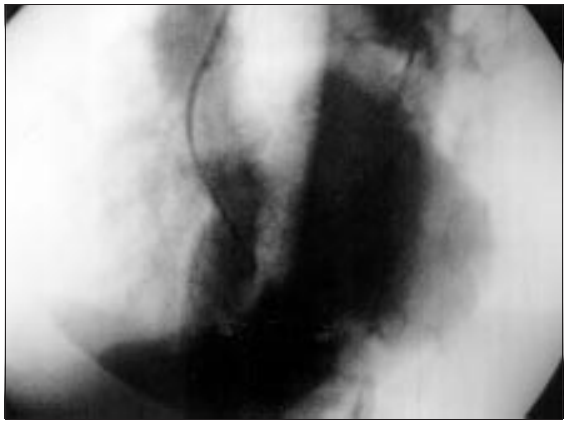
Fig. 3 – Ventriculografia esquerda evidenciando grande dilatação aneurismática posteriormente à parede posterior do ventrículo esquerdo sugerindo